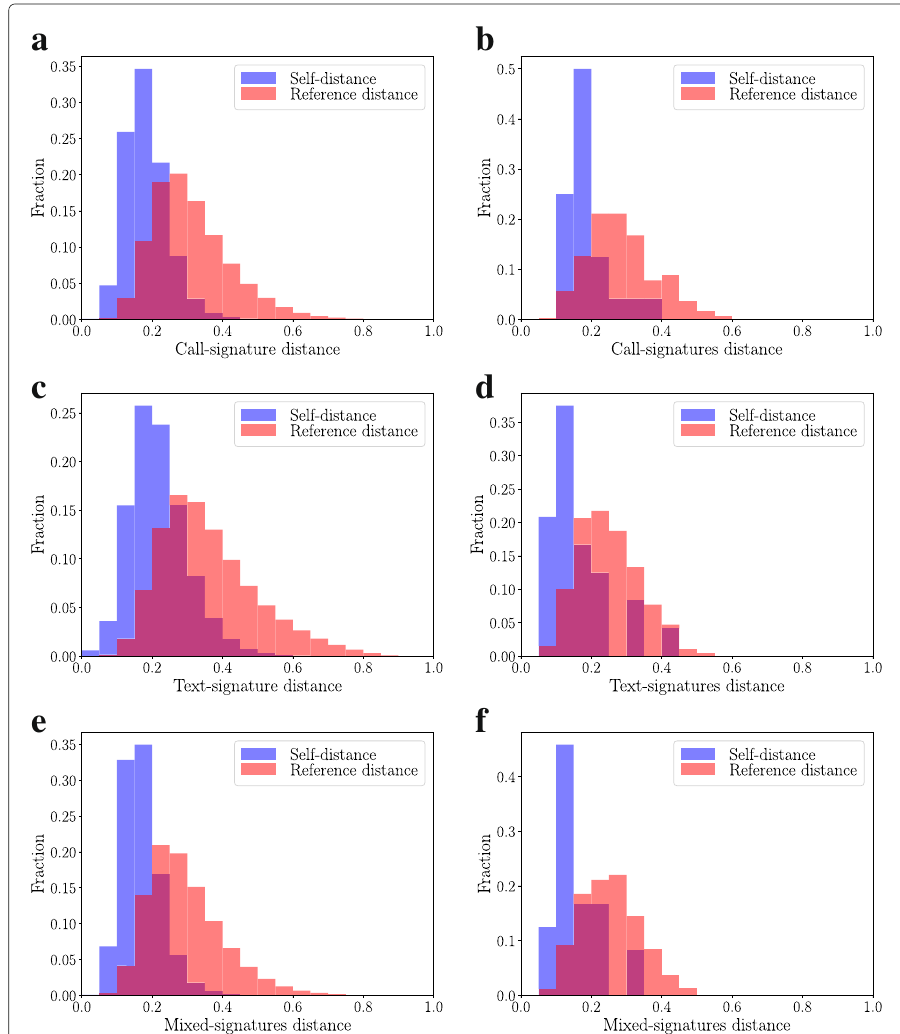
Fig. 2 Persistence of Social Signatures. Social signatures are persistent at the individual level. This holds for both channels (calls and texts) as well as mixed signatures combining both. Panels a , c , e : Dataset 1 (the large dataset), Panels b , d , f : Dataset 2 (students). The distributions of distances between social signatures of each ego in two consecutive equal-sized intervals are shown in blue (self–distances). The reference distributions of distances between signatures of different egos are shown in red (reference distances). Comparing the distributions of self–distances with reference distances verifies the persistence of call, text and mixed signatures, as self-distances are on average smaller than reference distances